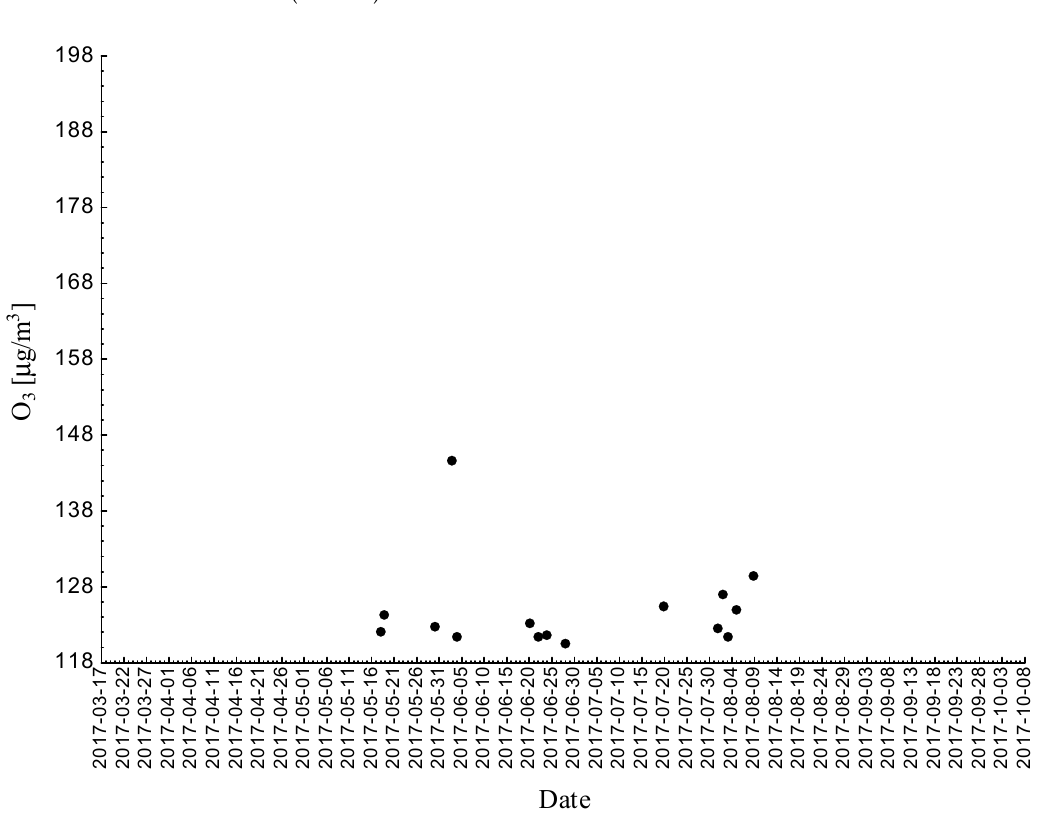
Figure 4. Maximum daily 8-h mean ozone concentration not less (equal to or more than) than 120.4 µ g/m 3 registered at the measurement station in Bielsko-Biała (SL15BB) in 2017.